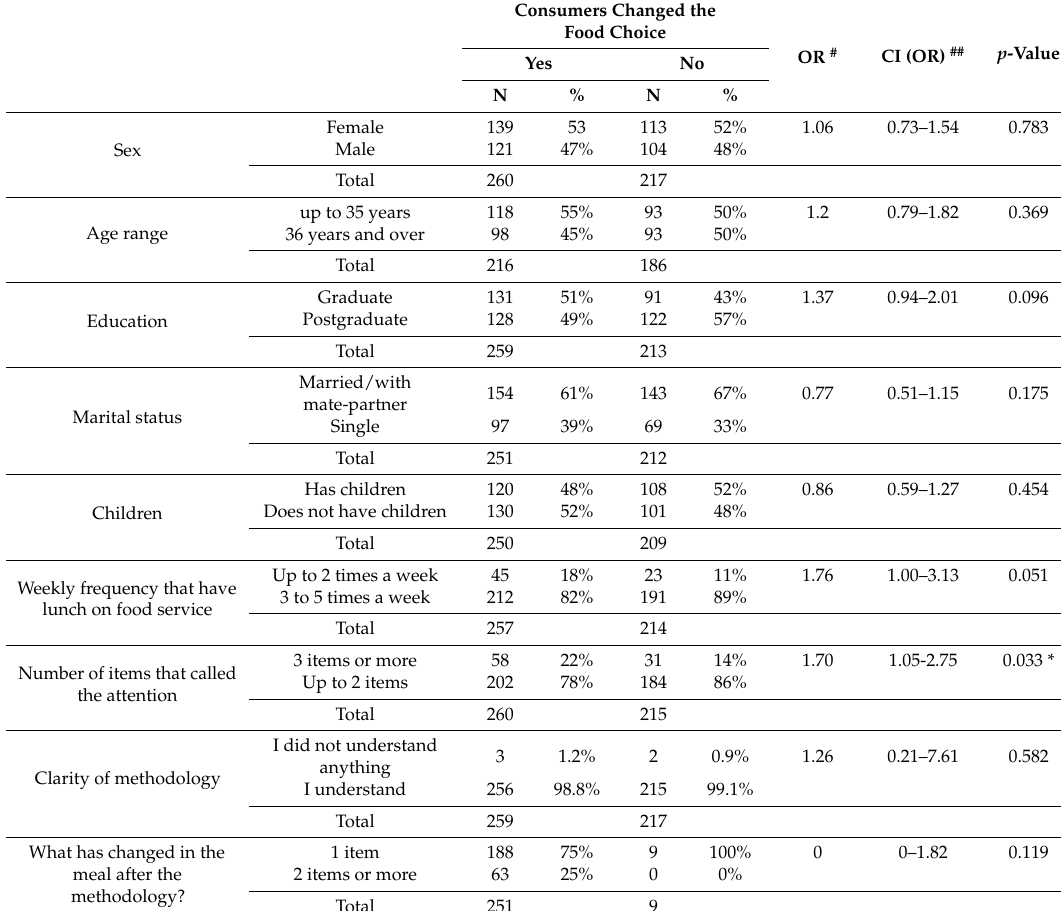
Table 3. Evaluation of the methodology by consumers that observed the nutritional education strategy and changes in food choices at a food service